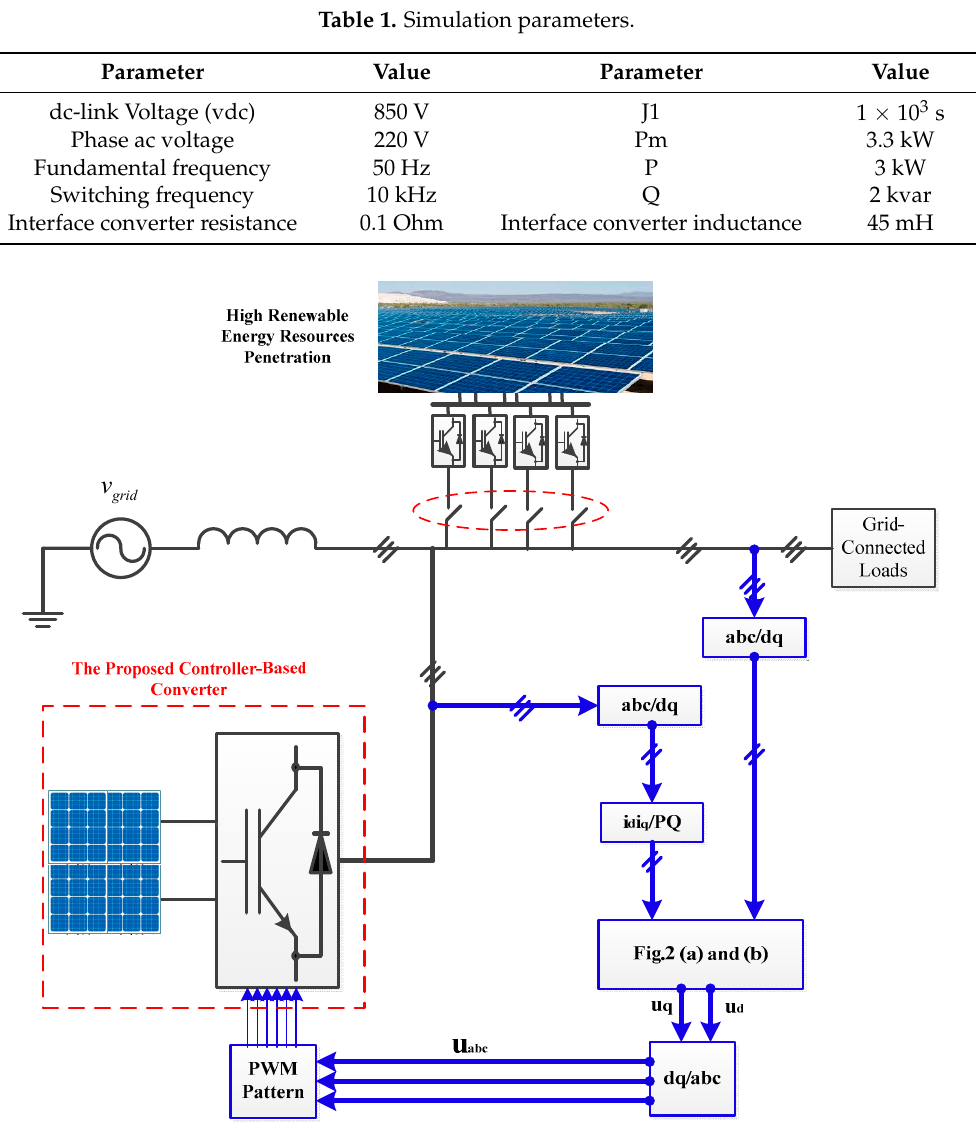
Figure 8. The general structure of the model based on the proposed control technique. PWM: Pulse Width Modulation; PQ: Active and Reactive Power Coordination.